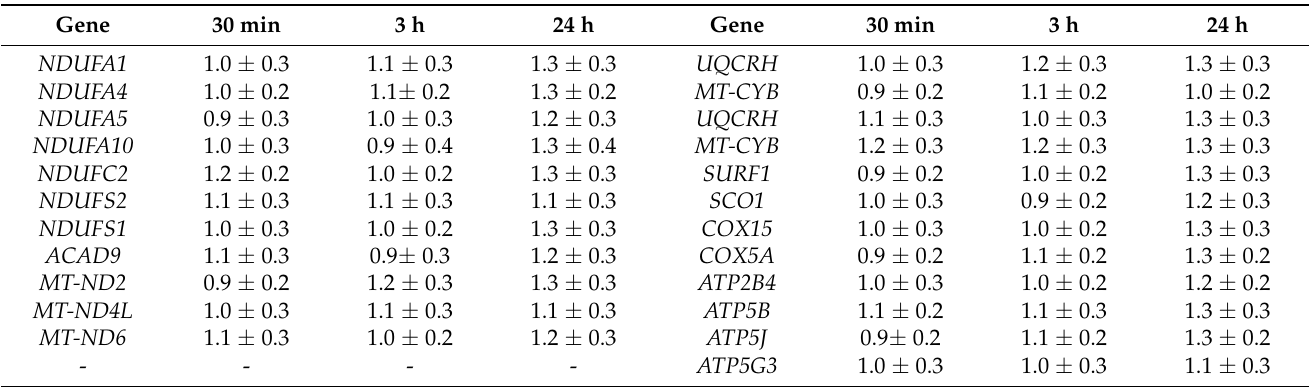
Table 1. Effects of non-oxidized DNA on the expression of the studied genes in MSC as ratios to control values (mean ± SD, n =